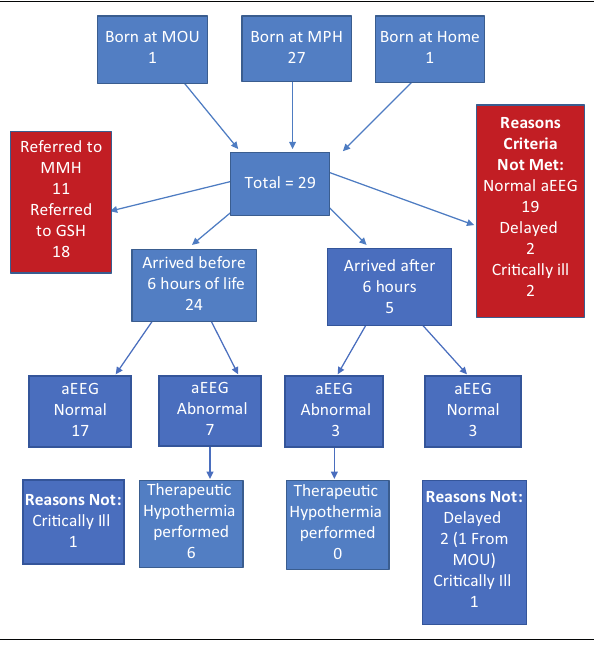
FIGURE 1: Overview of